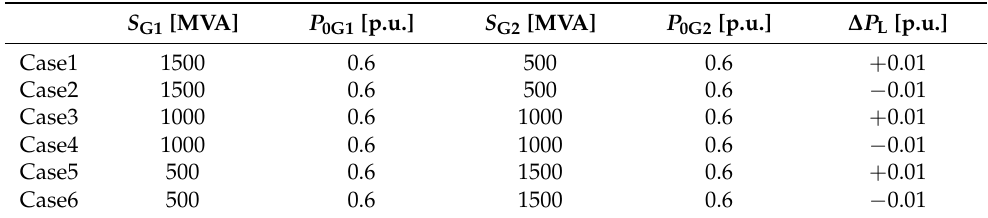
Table 4. Simulation parameters of the step changing load power fluctuation cases. The cases increasing load power can be regarded as simulating contingency. For each case, two simulation patterns with different PV module capacities are